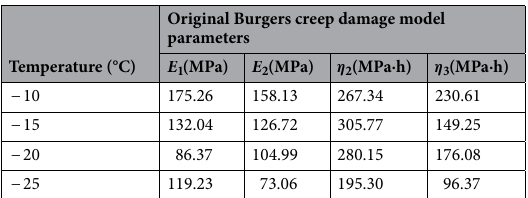
Table 1. Original parameters of the Burgers creep damage model (σ ≤ σ s ).